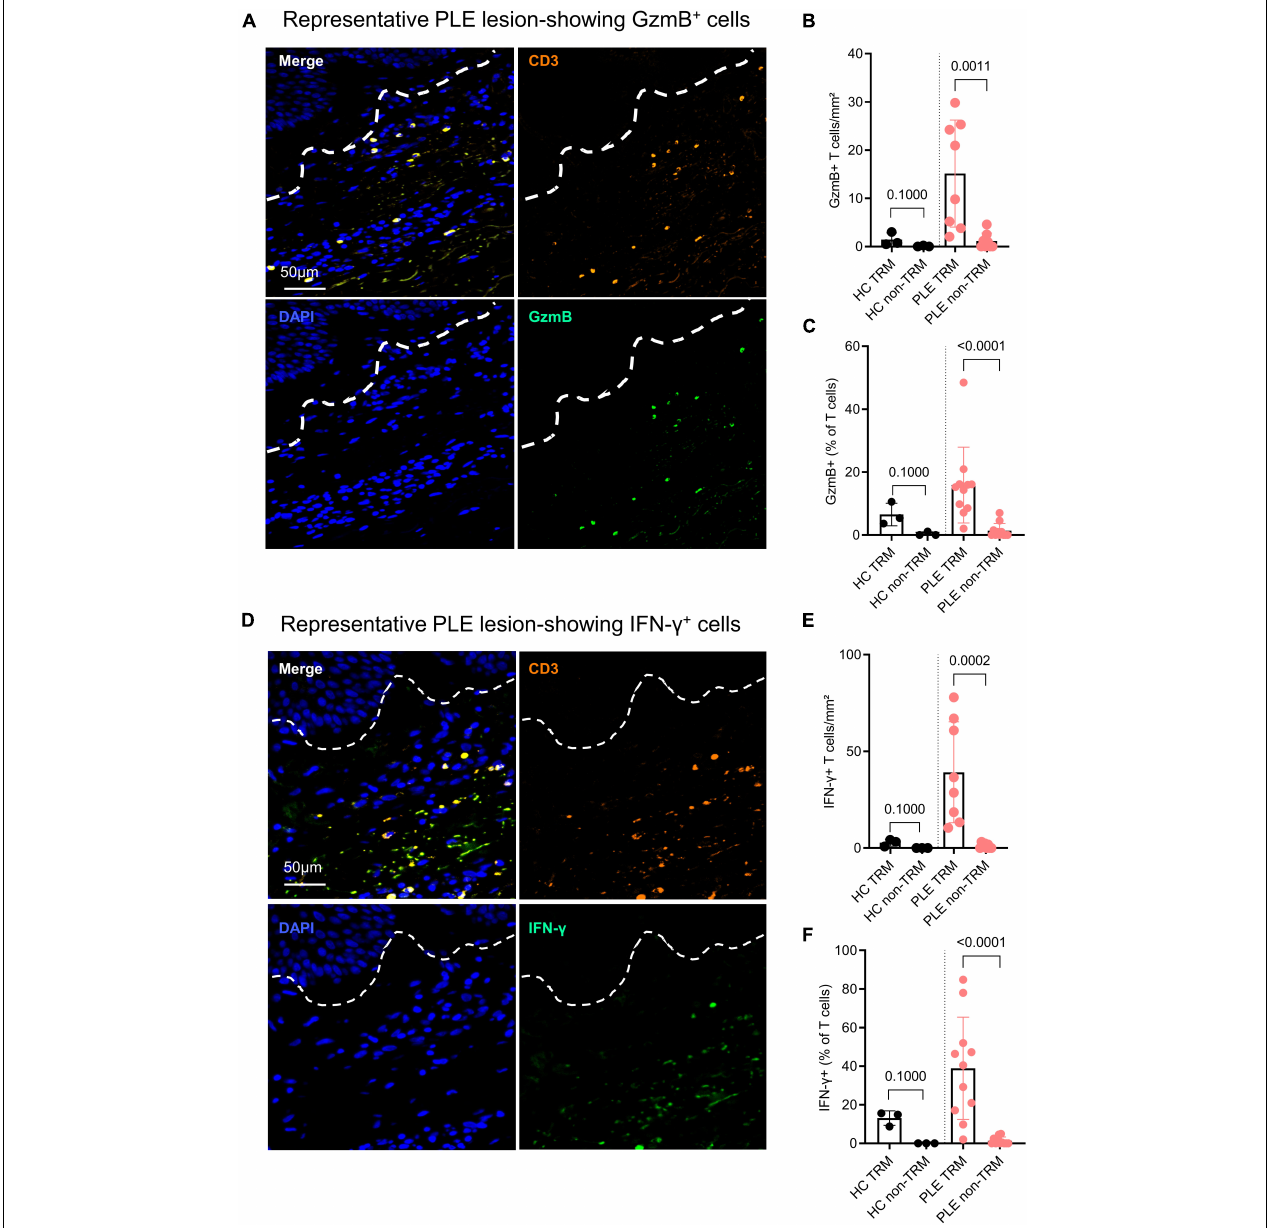
FIGURE 3 | Trm cells show high inflammatory cytokine production in active PLE lesions. (A,D) Representative IF images of granzyme B (GzmB) and interferon gamma (IFN- γ ) staining in a PLE lesion; dotted line indicates dermo-epidermal border. Production of GzmB (B) and IFN- γ (E) by T cells in PLE skin as compared to healthy control (HC) skin. Data shown as a mean number of positively stained CD3 + T cells/mm 2 ± SD. (C,F) Production of GzmB (C) and IFN- γ (F) by TRM (CD3 + CD69 + ) as compared to non-TRM (CD3 + CD69 − ) T cells. Data shown as a percentage of T cells ± SD positive for GzmB or IFN- γ . Statistical analysis with Mann–Whitney test (HC: n = 3, PLE: n =